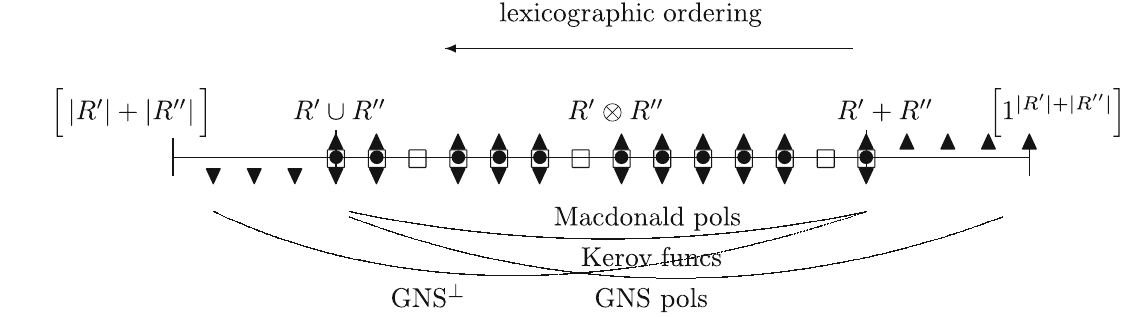
Fig. 1 Symbolic description of zeroes of the product decomposition